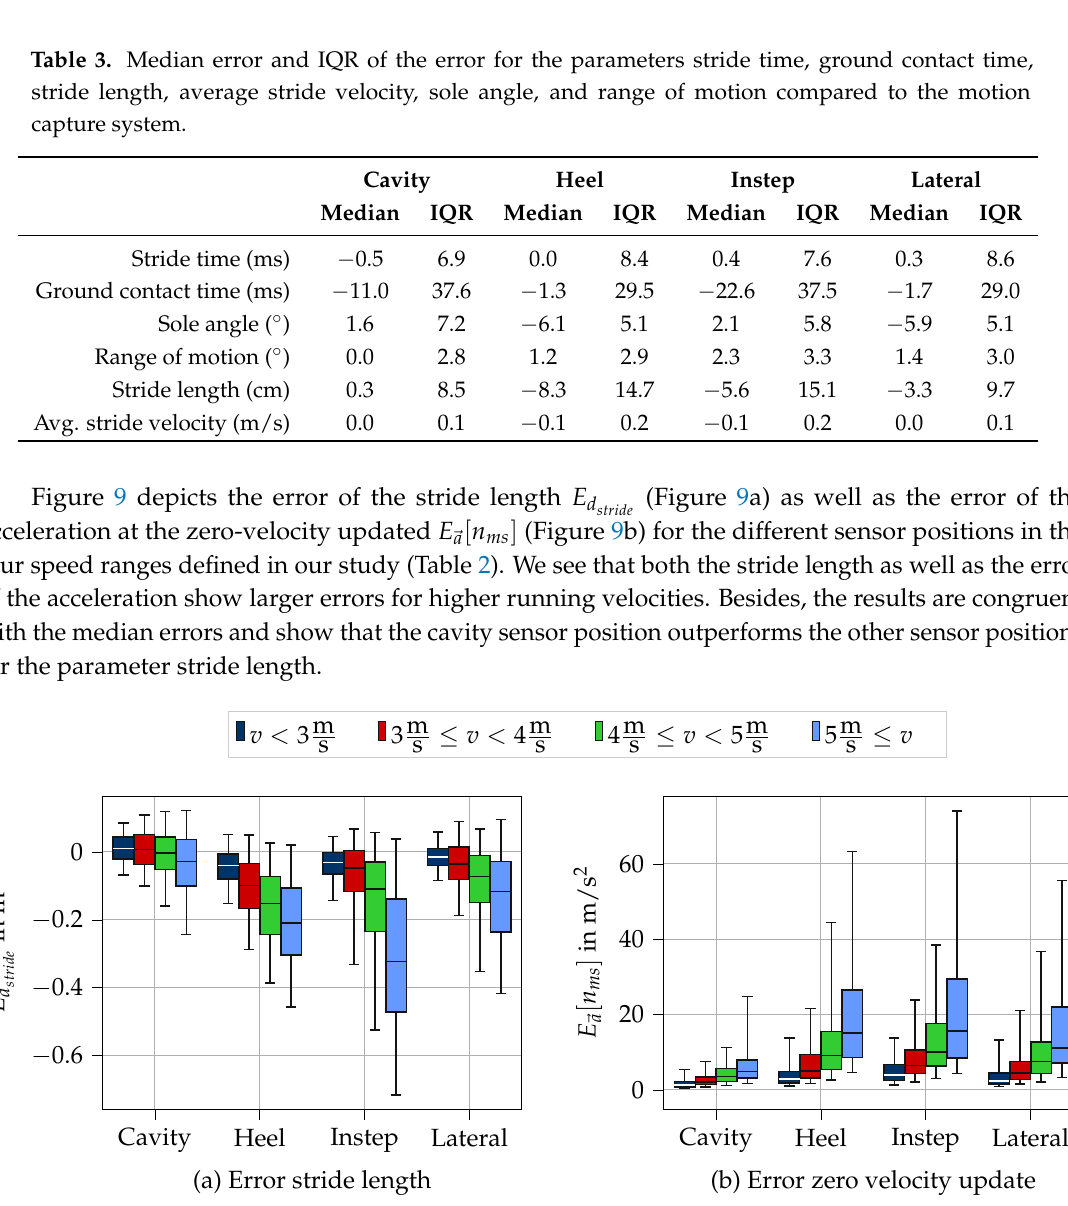
Figure 9. Visualization of the error for ( a ) stride length and ( b ) the acceleration at the zero-velocity update for the four different sensor positions in different speed